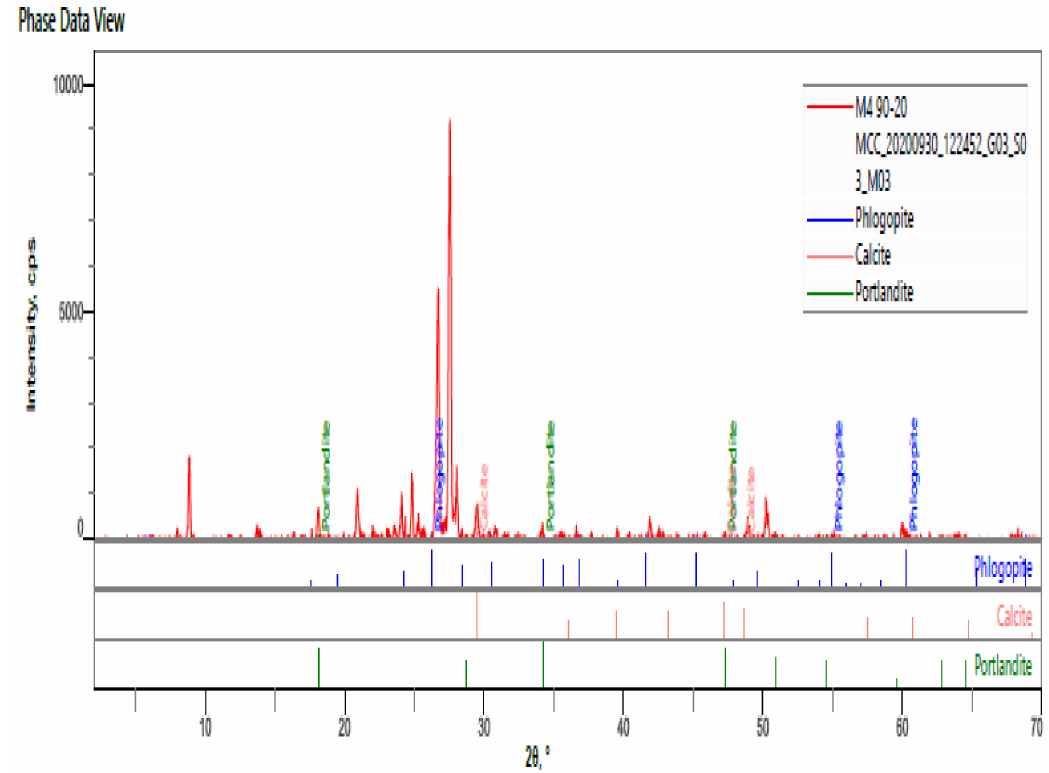
Figure 18. XRD pattern of the hardened MCCC-20 sample at 90